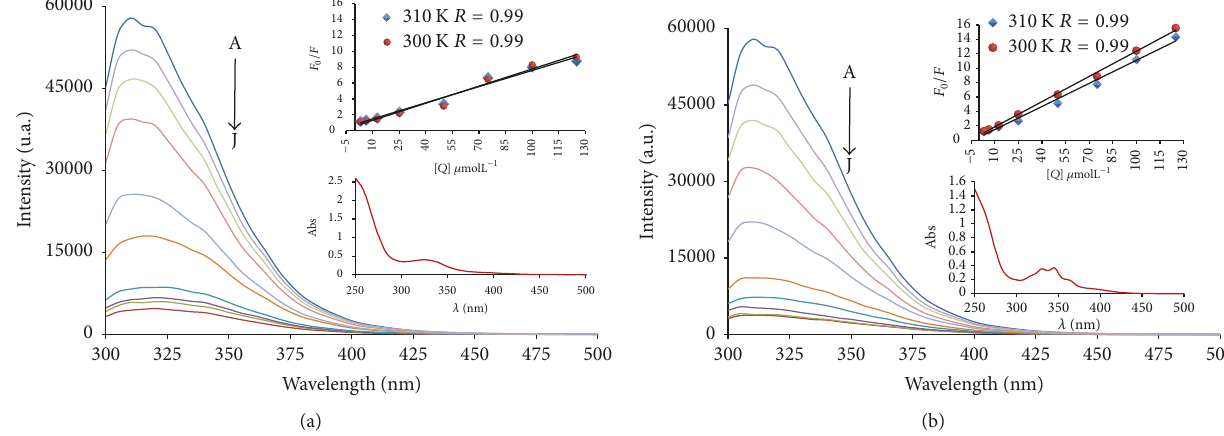
Figure 3: Fluorescence emission spectra of the BSA (2.5 𝜇 M 𝜆 ex 280 nm) at different concentrations of complexes 1 (a) and 2 (b) at 300 K. Inset: Stern-Volmer plots showing tryptophan quenching in BSA at 300 and 310K and UV-vis spectra of complexes 1 and 2